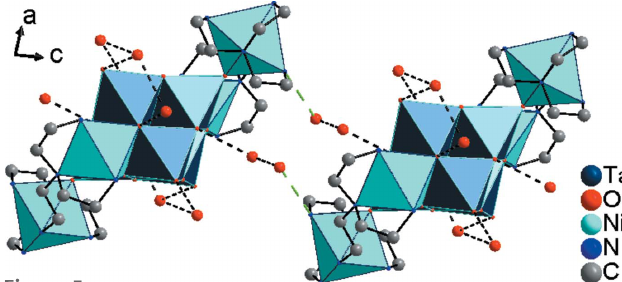
Figure 4 View of the hydrogen-bonded chains running parallel to [010]. Inter- molecular hydrogen bonding is indicated by dashed lines. In the left part, hydrogen atoms were omitted for clarity.